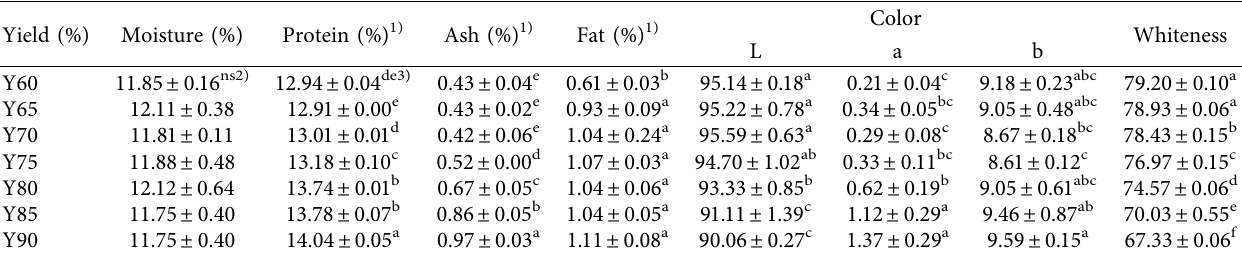
Table 3: Moisture, protein, ash and fat contents, color, and whiteness of wheat flour (var. Jokyoung) according to flour yield. Yield